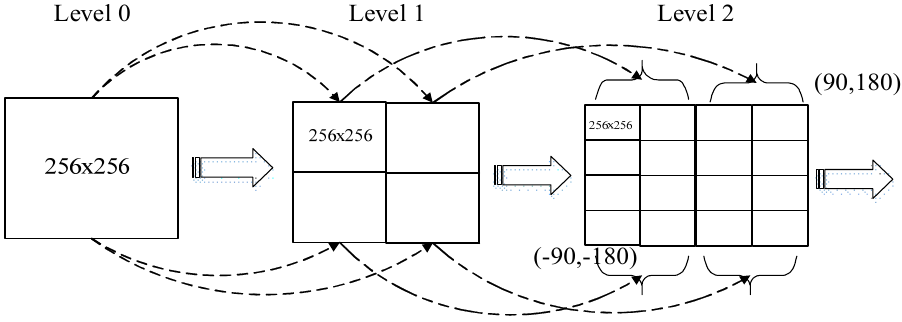
Figure 2. Quadtree-based tile-clipping pattern for global map tile generation.